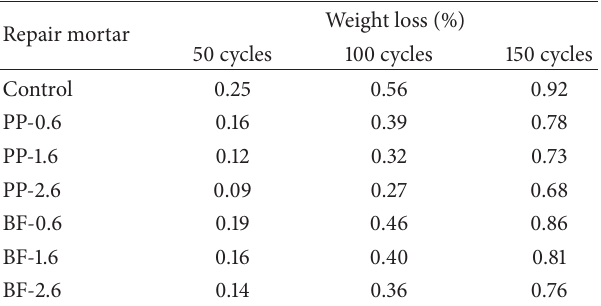
Table 7: Weight loss of the mortar specimens after the freeze-thaw